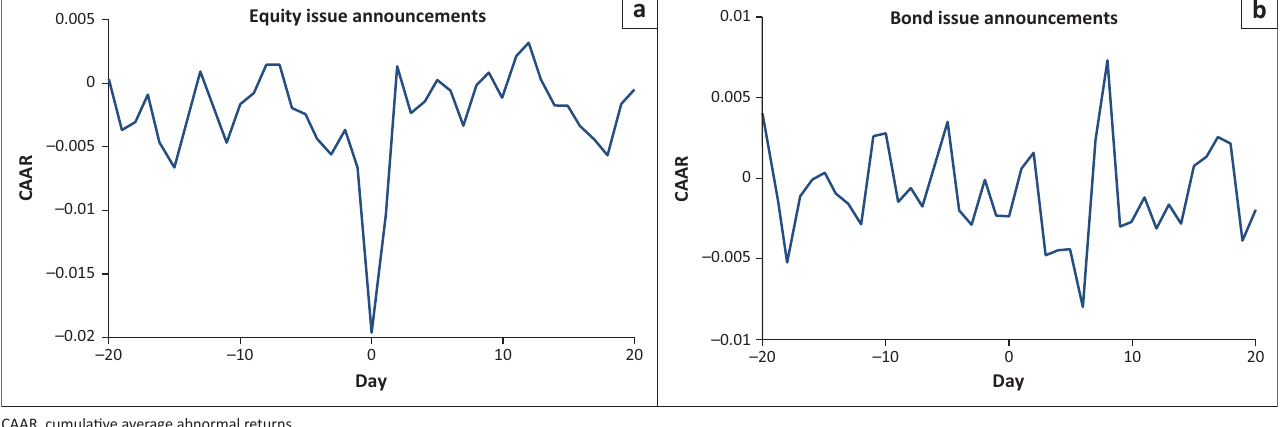
FIGURE 1: Cumulative average abnormal returns for equity and bond announcements